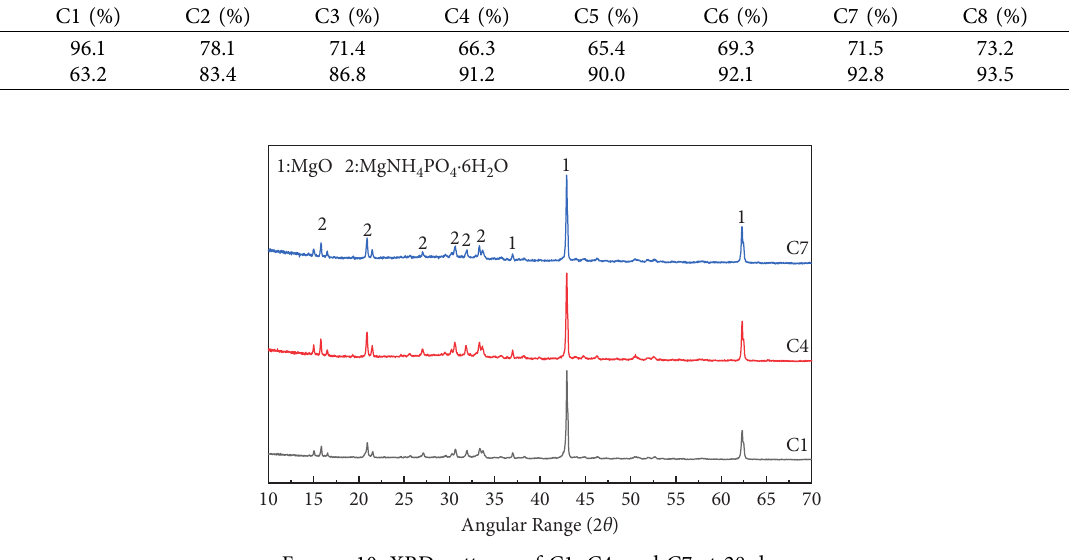
Figure 10: XRD patterns of C1, C4, and C7 at 28 days.